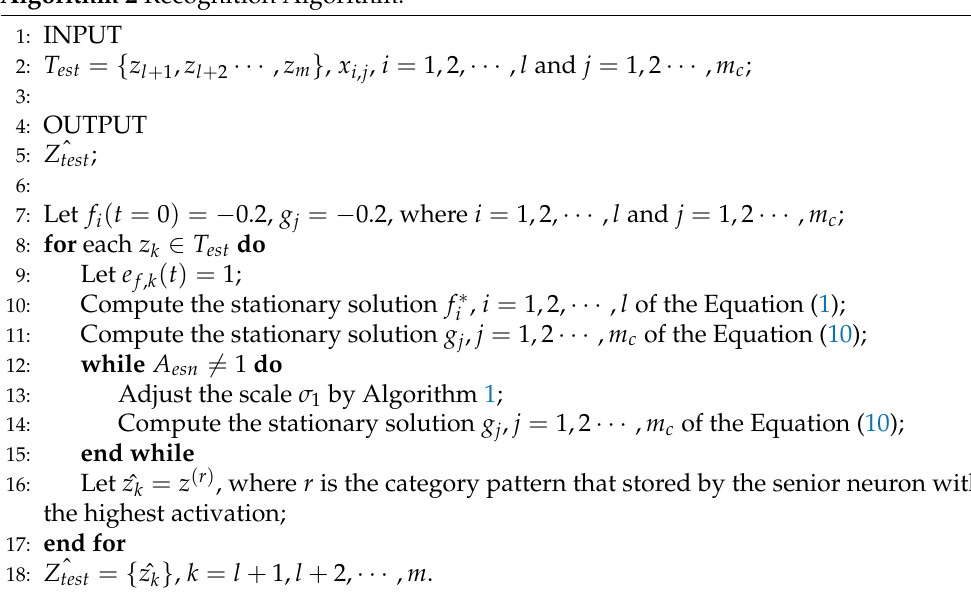
Algorithm 2 Recognition Algorithm.